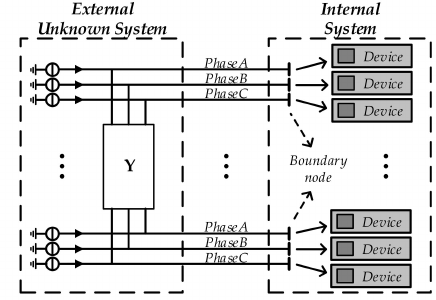
Figure 2. Setting the location of measuring